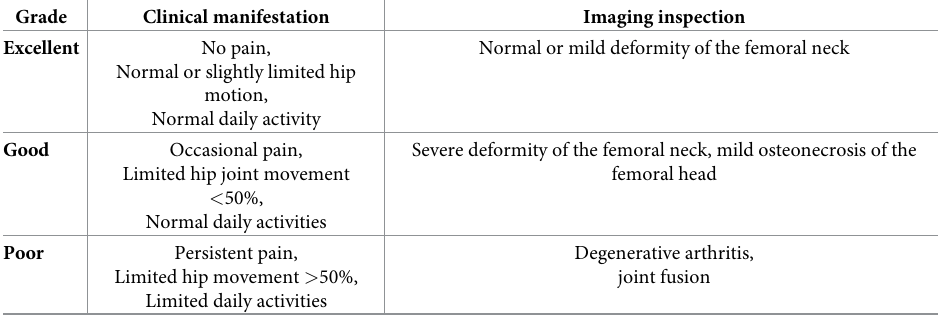
Table 1. Ratliff scoring